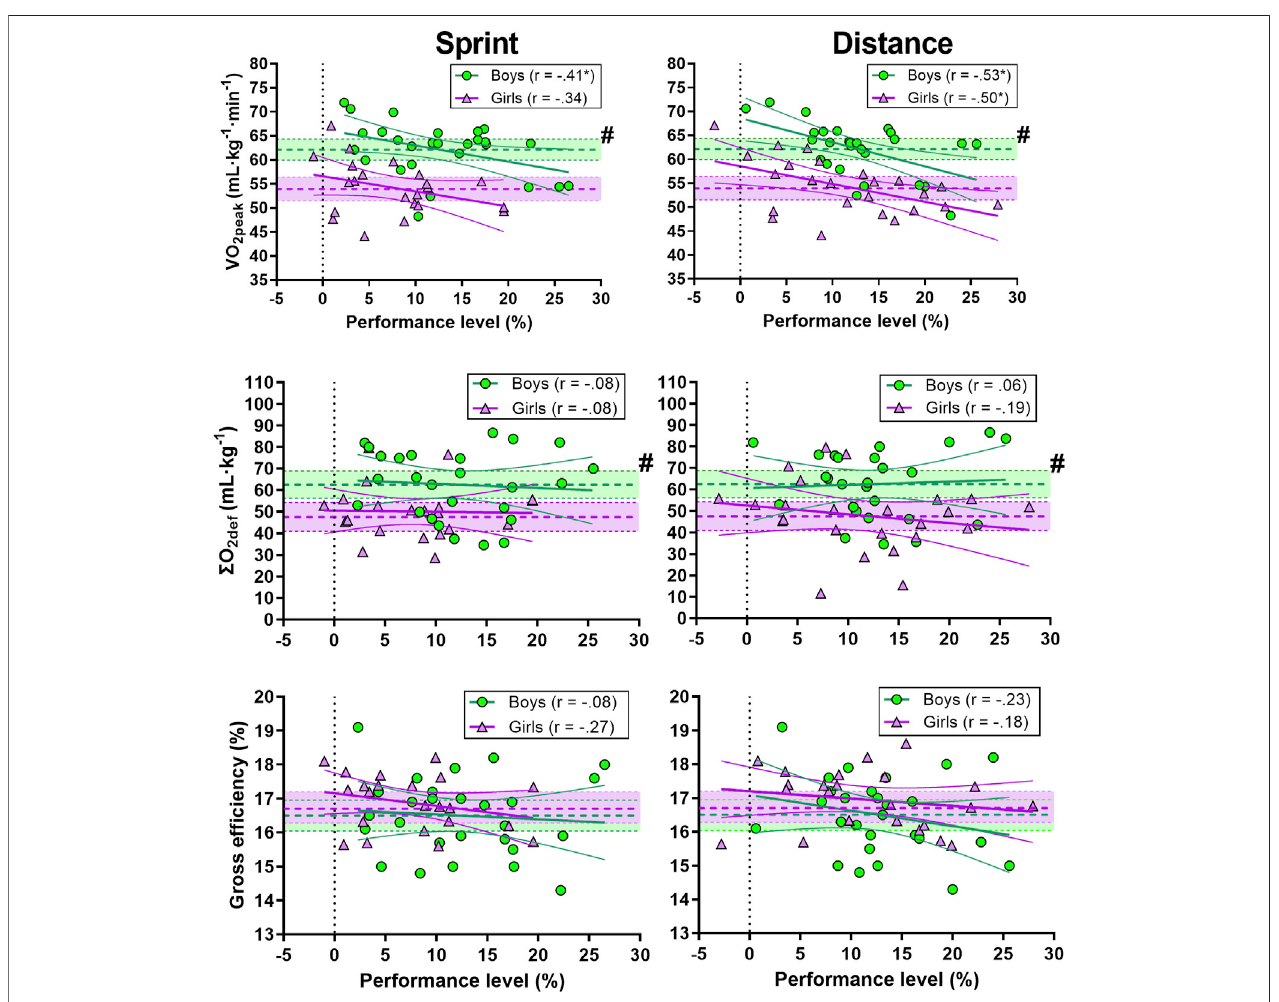
FIGURE 6 | Correlation between sprint (left panel) and distance performance (right panel) and V _ O 2peak , Σ O 2def and gross ef fi ciency (GE). Green circles represent individual values for the boys. Purple triangles represent individual values for the girls. Shaded areas with dotted lines in the middle represent mean ±95% con fi dence interval(CI)(greenareafortheboysandpurpleforthegirls).Thickandnarrowlinesrepresentthebest fi tregressionlineandthe95%con fi dencebands(greenlinesforthe boysandpurpleforthegirls).Seethemethodsection foranexplanationoftheperformancelevel.*Correlation issigni fi cantat the0.05level.#signi fi cantdifference between boys and